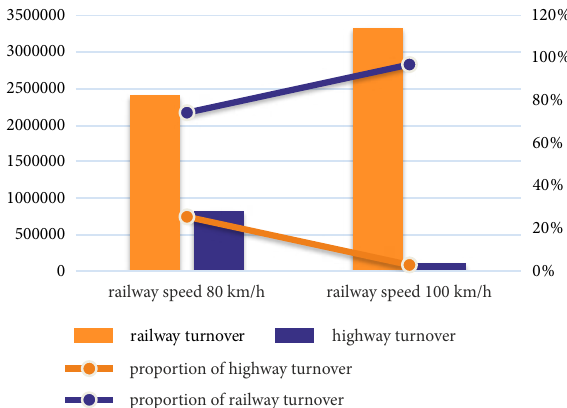
Figure 5. Comparison chart of freight turnover between railway and highway under different transport